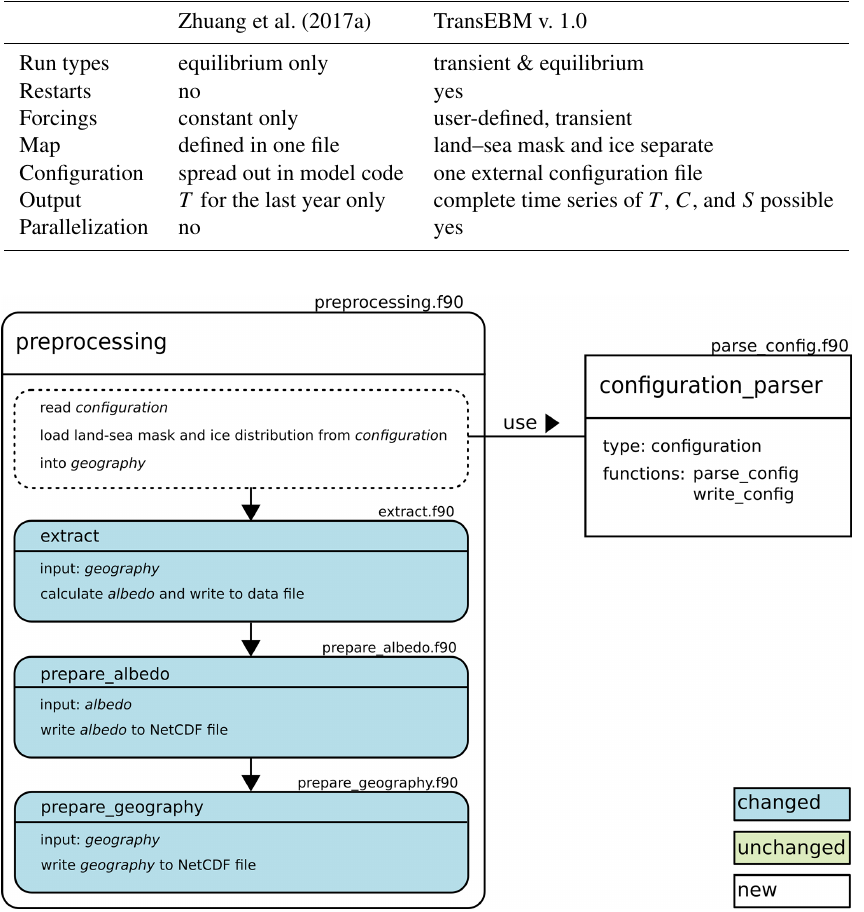
Table 4. Features of the revised model, TransEBM v. 1.0, in comparison to the model by Zhuang et al. (2017a).